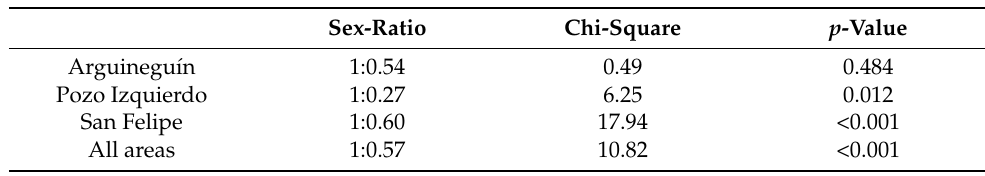
Table 2. Sex ratio of Percnon gibbesi caught in intertidal areas of Gran Canaria between July 2020 and